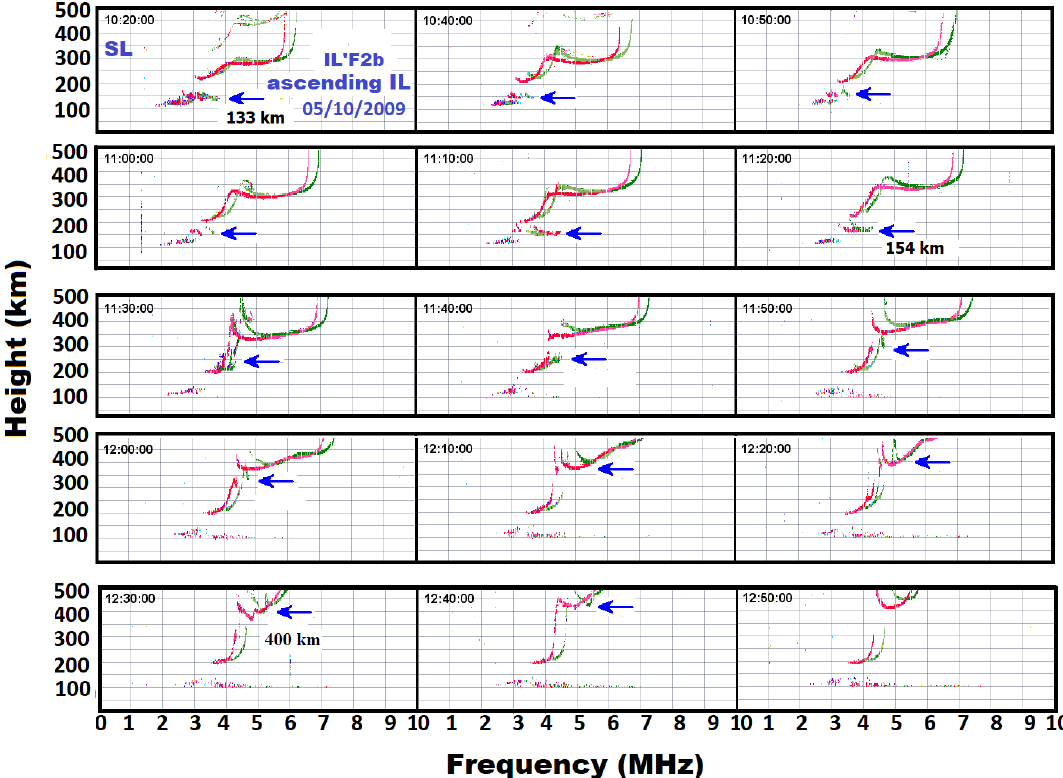
Figure 8. Sequence of ionograms taken during 10:20–12:50UT on 5 October 2009 showing the presence of ascending intermediate layers over São Luís. The blue arrow indicates more clearly the rise of